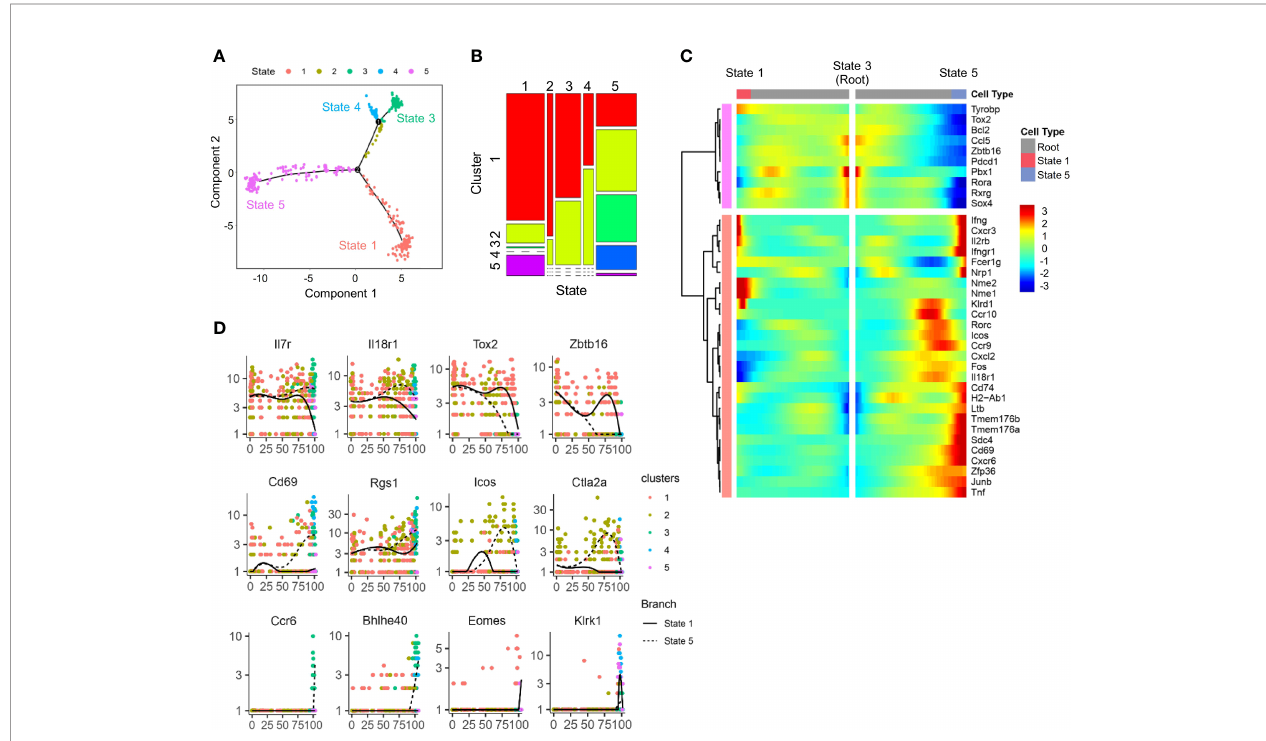
FIGURE 4 | Trajectory analysis of scRNA-seq IL-18Ra + BM progenitor cells. (A) A single cell trajectory was constructed from the dataset in Figure 2D (Cluster 6 cells) using Monocle package. Five distinct states were identi fi ed along the trajectory. (B) Distribution of fi ve clusters identi fi ed in Figure 2D at fi ve states along the trajectory in panel (A, C) Heatmap shows the expression pro fi les of lymphoid progenitor-associated and ILC-associated genes in fi ve states along the trajectory in panel (A, D) Expression changes of the indicated genes related to ILCP and committed or differentiated ILCs along pseudotime from state 3 to state 1 and state 5 in panel (A)